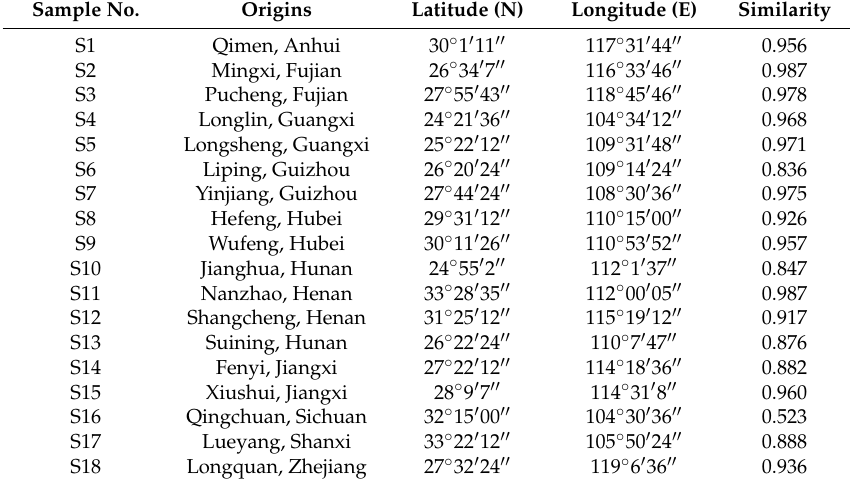
Figure 1. HPLC chromatographic fingerprints of the 18 C. paliurus samples and the reference fingerprint (R) obtained by the Similarity Evaluation System for Chromatographic Fingerprint of Traditional Chinese Medicine software (Version 2004A, Chinese Pharmacopoeia Committee, Beijing, China). The peaks marked with 1–21 represent the 21 characteristic common peaks. Table 1. The geographical information and similarity values of leaf samples of C. paliurus. Sample No.